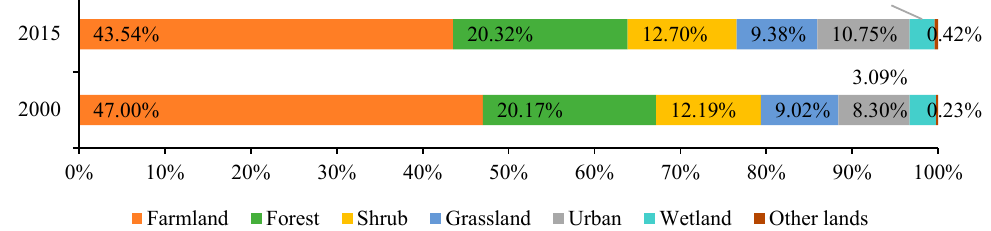
Figure 3. Proportion of ecosystems in the Beijing–Tianjin–Hebei urban agglomeration in 2000 and 2015 .